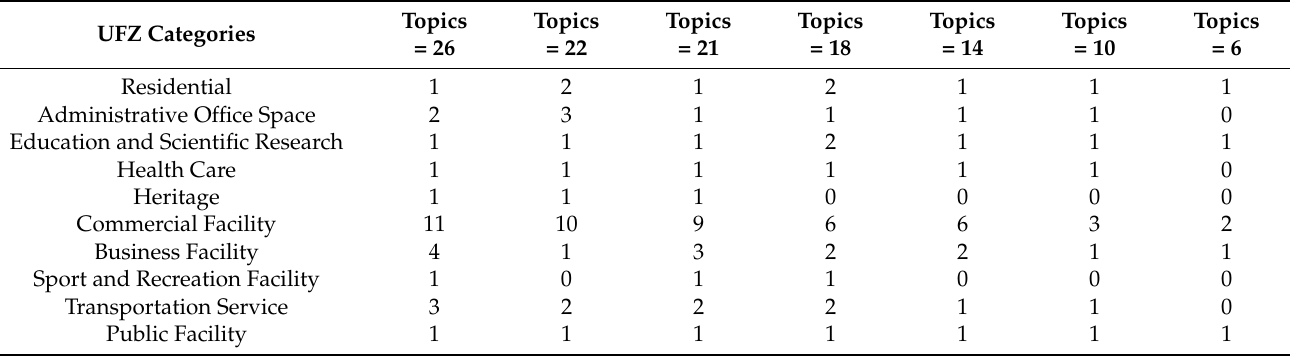
Table 4. Parameter influence analysis with the number of topics.